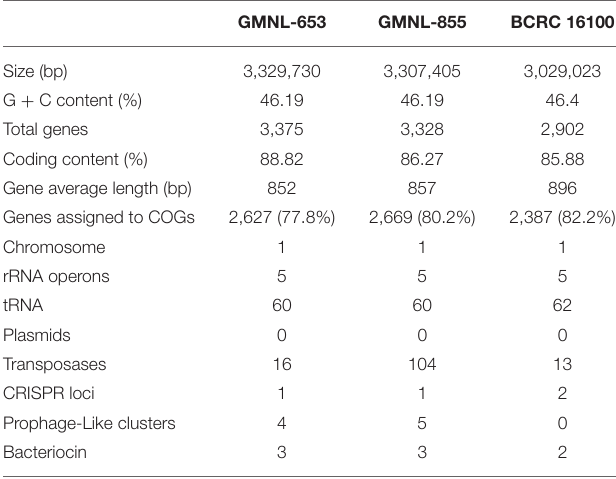
TABLE 2 | General features of L. paracasei